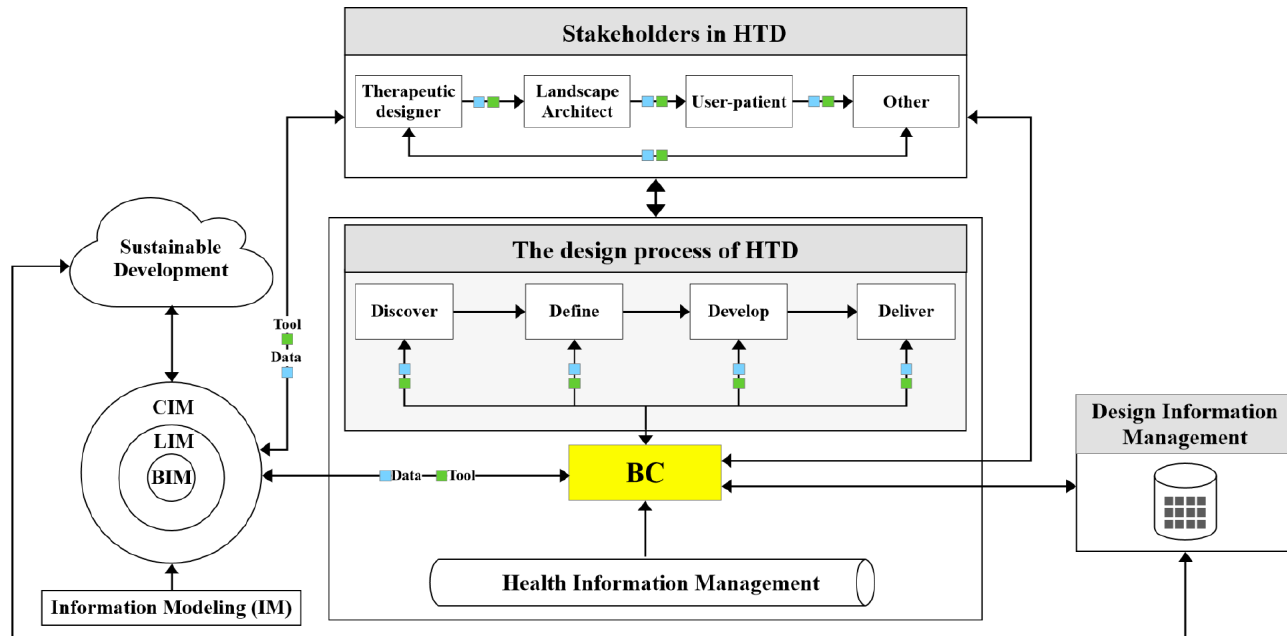
Figure 5. The process of HTD enhanced by BC (generated by